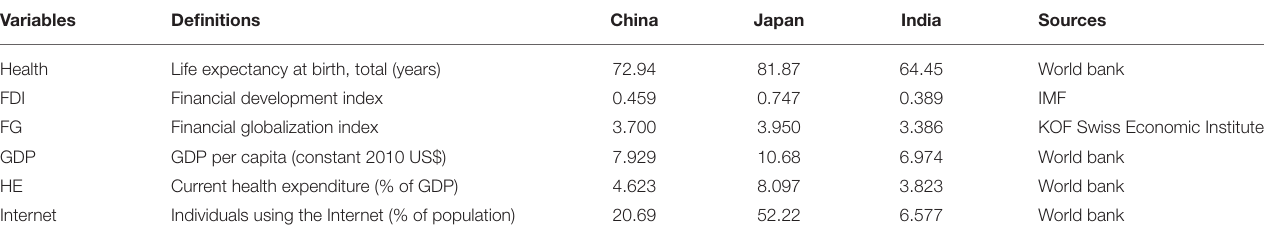
TABLE 1 | Data definitions, description, and sources.